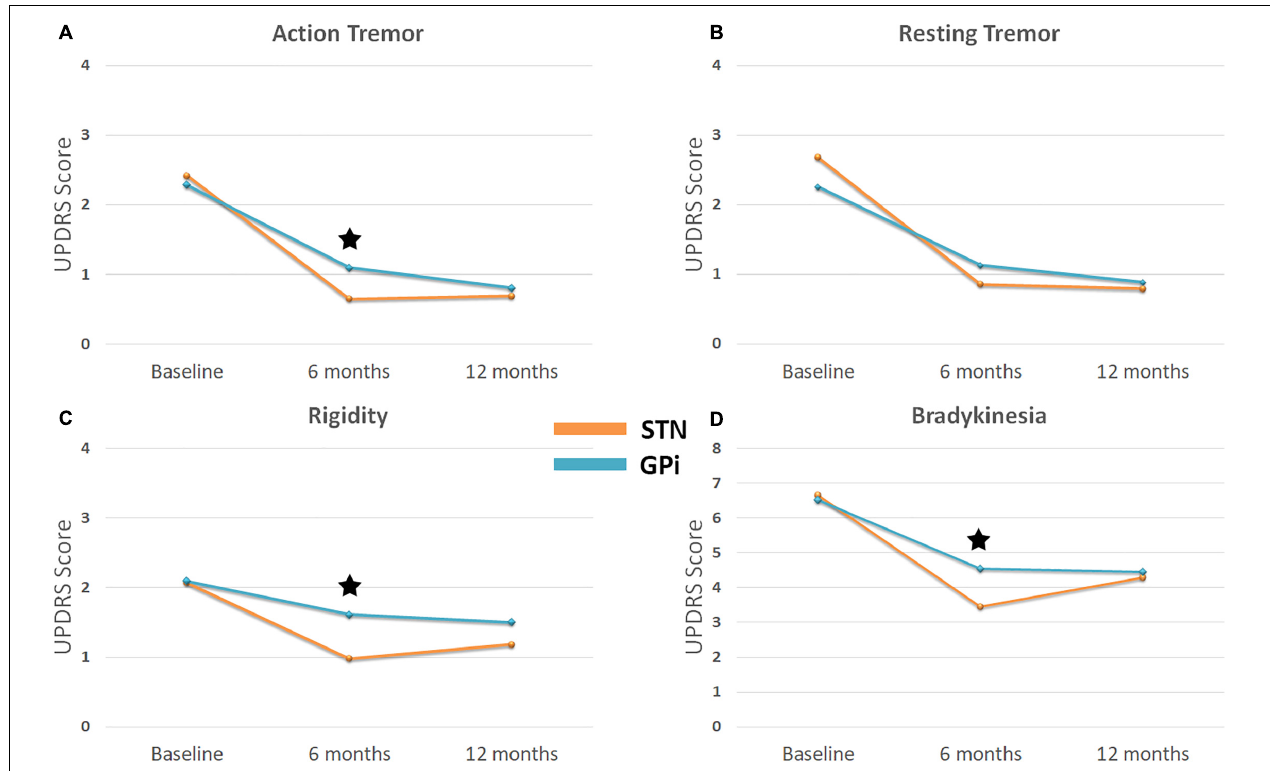
FIGURE 2 | Line graph illustrates outcomes for (A) action tremor (B) rest tremor (C) rigidity and (D) bradykinesia for STN DBS versus GPi DBS. Blue line represents STN DBS and orange line represents GPi DBS. Baseline represents UPDRS item scores before surgery. UPDRS item 20 applicable to contralateral arm was used for assessment of rest tremor, item 21 for action tremor, item 23 for rigidity and summation of items 23, 24, and 25 for bradykinesia. Scores at 6 and 12 months after DBS were obtained in during OFF medication – ON stimulation state. *Denotes a statistically significant difference between the two